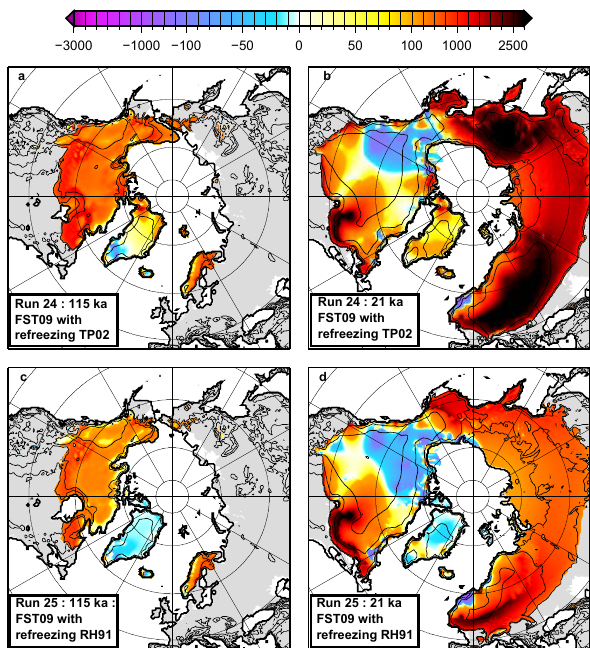
Fig. 6. Simulated ice thickness difference (in m) when substituting the TP02 refreezing scheme in the FST09 model (FST09–FST09 with TP02 refreezing, top panels, run 24), and when allowing in the FST09 model a fixed portion (i.e., Pmax = 60%) of meltwater to produce superimposed ice (FST09–FST09 with RH91 refreezing, bottom panel, run 25). Left panels refer to the 115ka period and right panels refer to the LGM (i.e., 21ka). The thick black lines represent the contour of the continents and the thin ones display the iso-contours of surface elevation (from 1000 to